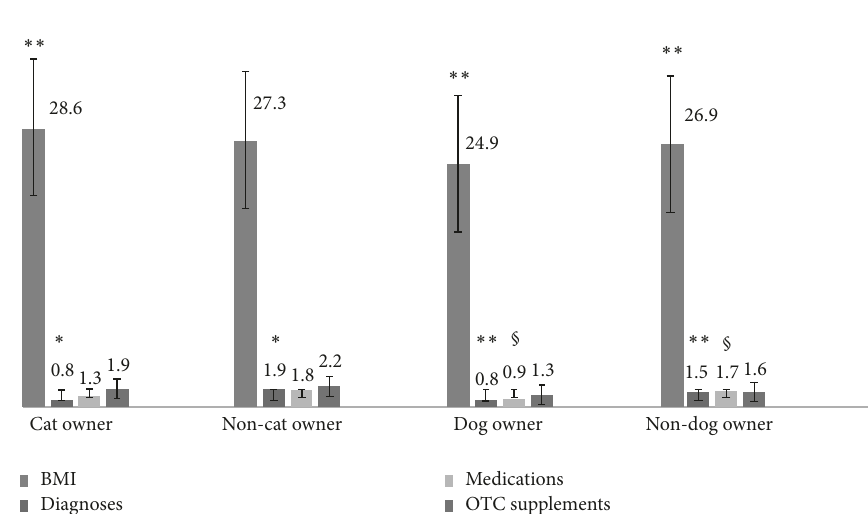
Figure 1: Characteristics of older pet owners versus matched nonowners > 50 years residing in the rural United States ( 𝑁 = 168 ). ∗ 𝑝 < 0.01 , ∗∗ 𝑝 < 0.05 , and § 𝑝 < 0.004